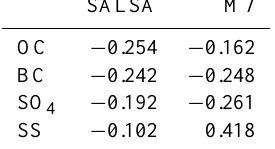
Fig. 5. Observed and simulated annual median size distributions for six measurement stations (a) Pallas, (b) Jungfraujoch, (c) Aspvreten, (d) Melpitz, (e) Mace Head and (f) Hyyti¨al¨a. Simulated size distribution for M7 is plotted in blue solid line. Simulated size distributions for SALSA are plotted with red solid line indicating activation type nucleation and with red dashed line for binary nucleation. Observed annual median size distributions are plotted in black, with dashed black lines showing the 95th and 5th percentiles of observed concentrations (Asmi et al., 2011). Table 8. Simulated mean fractional bias between observations at IMPROVE stations and modelled values with SALSA and M7 for organic carbon, black carbon sulphate and sea salt.